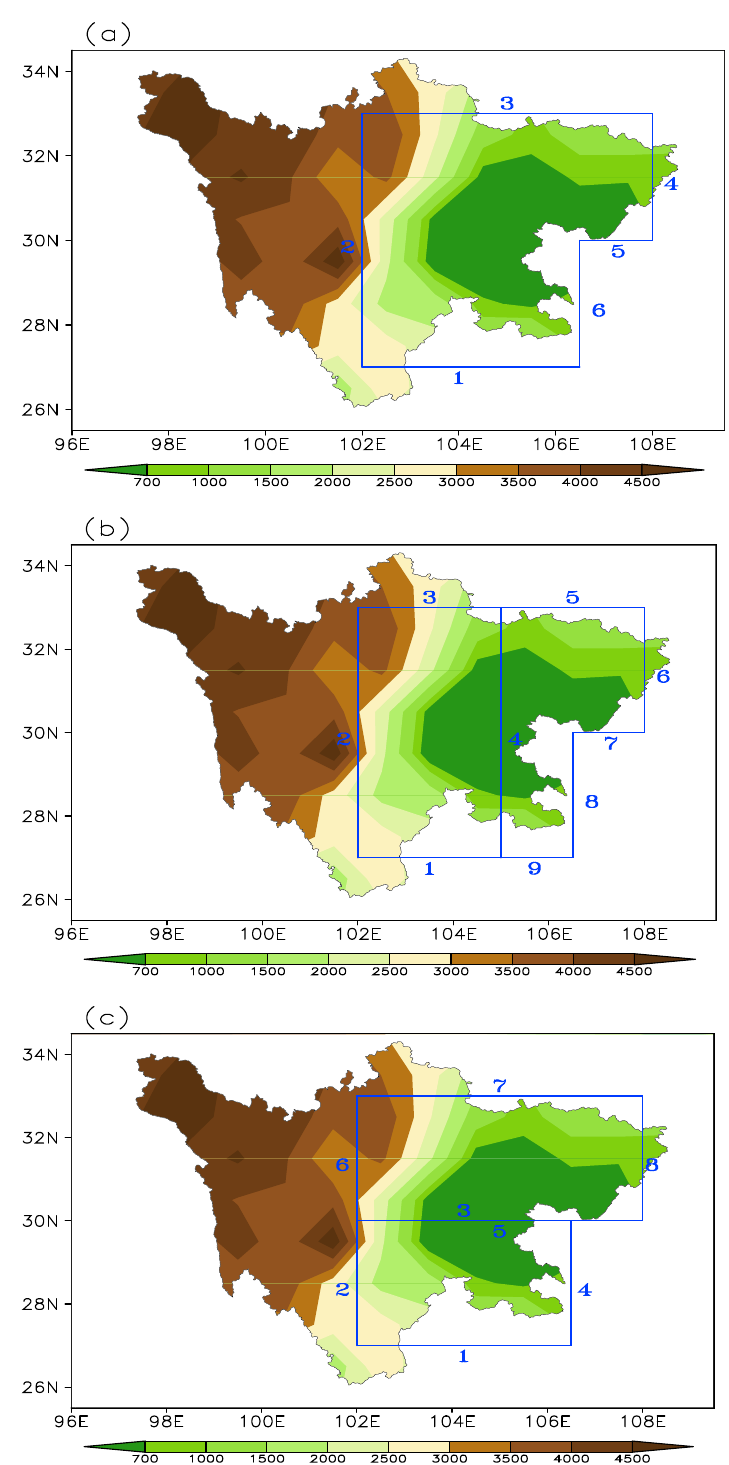
Figure 1. The boundaries of the Sichuan Basin and the sub-basins. (Map shows the topography of Sichuan Province, different colors indicate terrain height, units: m. The boundary shows the Sichuan province, and the rectangles outline the Sichuan Basin. ( a ) The Sichuan Basin; ( b ) eastern and western basin; ( c ) northern and southern basin).